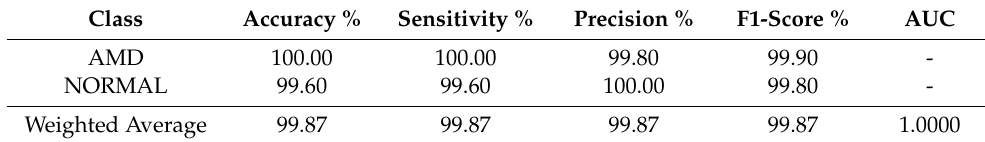
Table 3. Quantitative results of the proposed method on the UCSD test set.